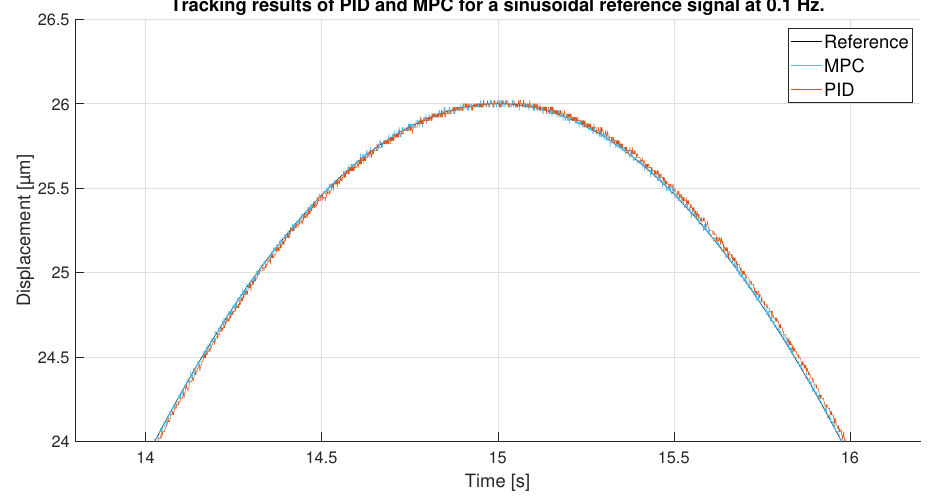
Figure 15. Zoom of tracking results of PID and MPC for a 0.1 Hz sinusoidal reference.